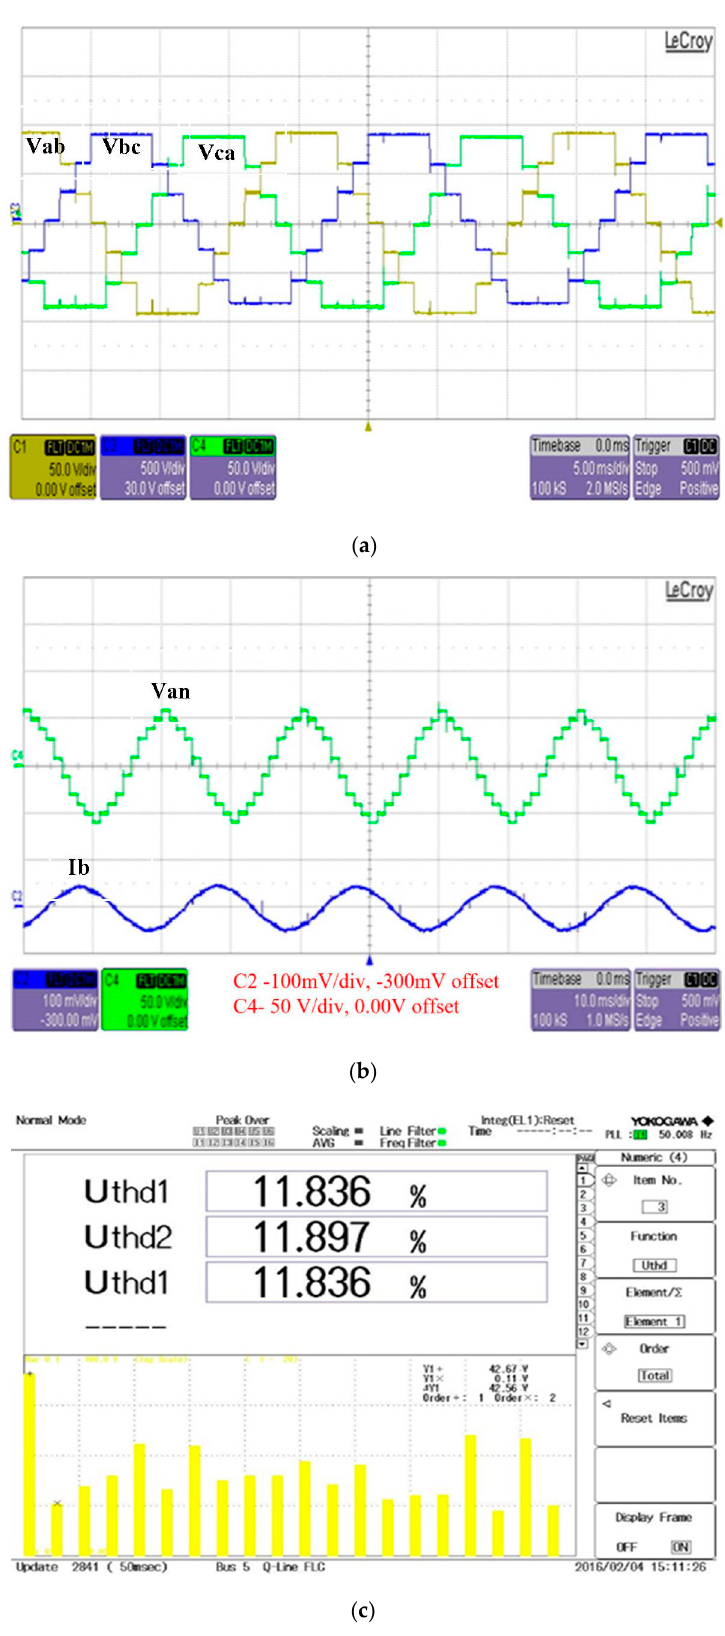
Figure 12. The experimental results for 4LT 2 C when connected to 0.3 kW induction motor load. ( a ) Line-to-line voltage. ( b ) Line-to-neutral voltage with load current. ( c ) The total harmonic distortion (THD) of the proposed topology. Table 9. Comparison of neutral point clamped (NPC), cascaded H-bridge (CHB), flying capacitor (FC), and NLT 2 C in terms of rating requirement per the N level.